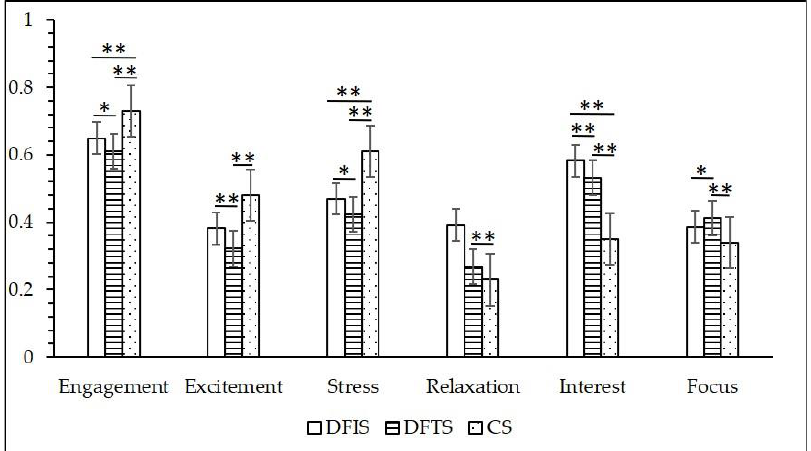
Figure 5. Neural emotional parameter values for the three stimulating environments ( n = 120; mean ± SD; * p < 0.05; ** p < 0.01; verified by a paired t test, DFIS: deciduous forest interior setting; DFTS: deciduous forest trail setting; CS: city setting).